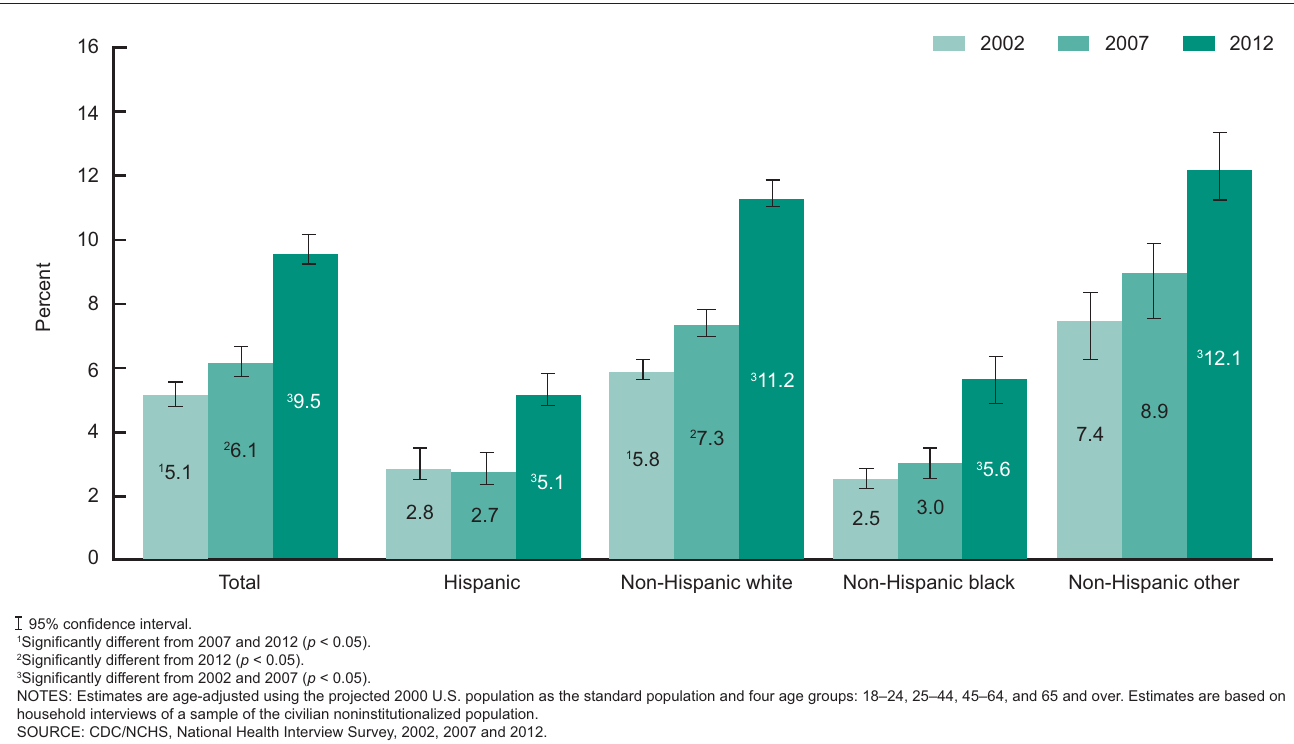
demonstrated a similar pattern of use across time (2.5% in 2002, 3.0% in 2007, and 5.6% in 2012) (Figure